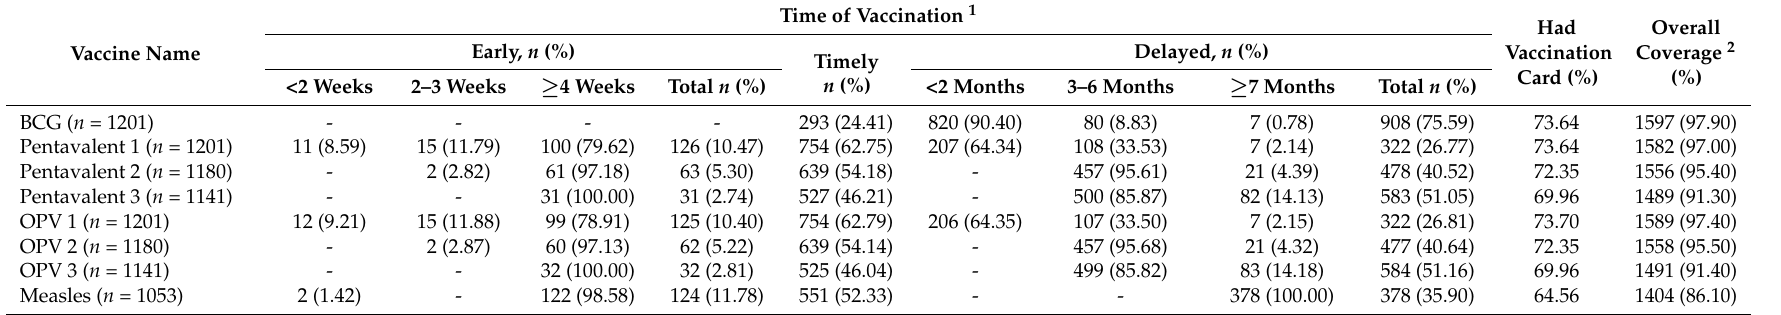
Table 3. Adherence to the vaccination schedule for recommended vaccines in Bangladesh based on the Demographic and Health Survey (BDHS)